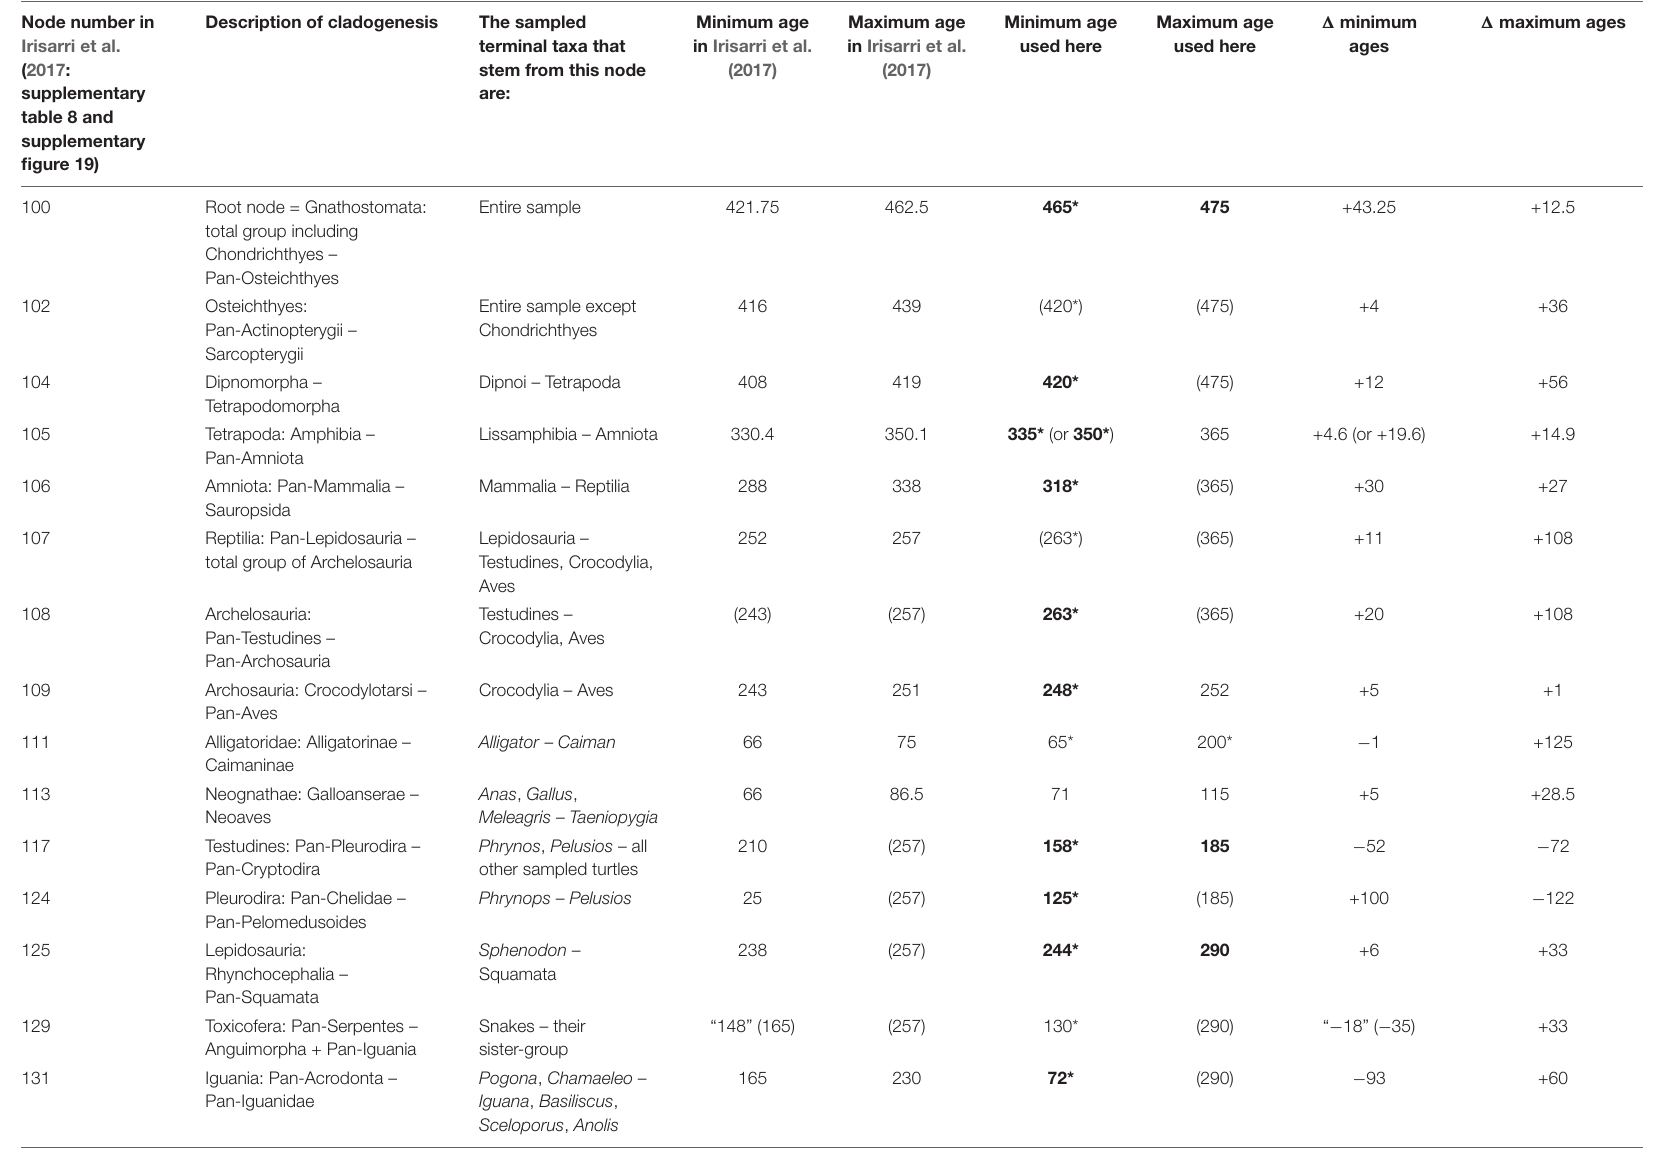
TABLE 1 | The first four columns of Irisarri et al. (2017: supplementary table 8), here expanded to five, followed by the ages used here for the same calibrations and the differences ( (cid:49) ). Node number in Irisarri et